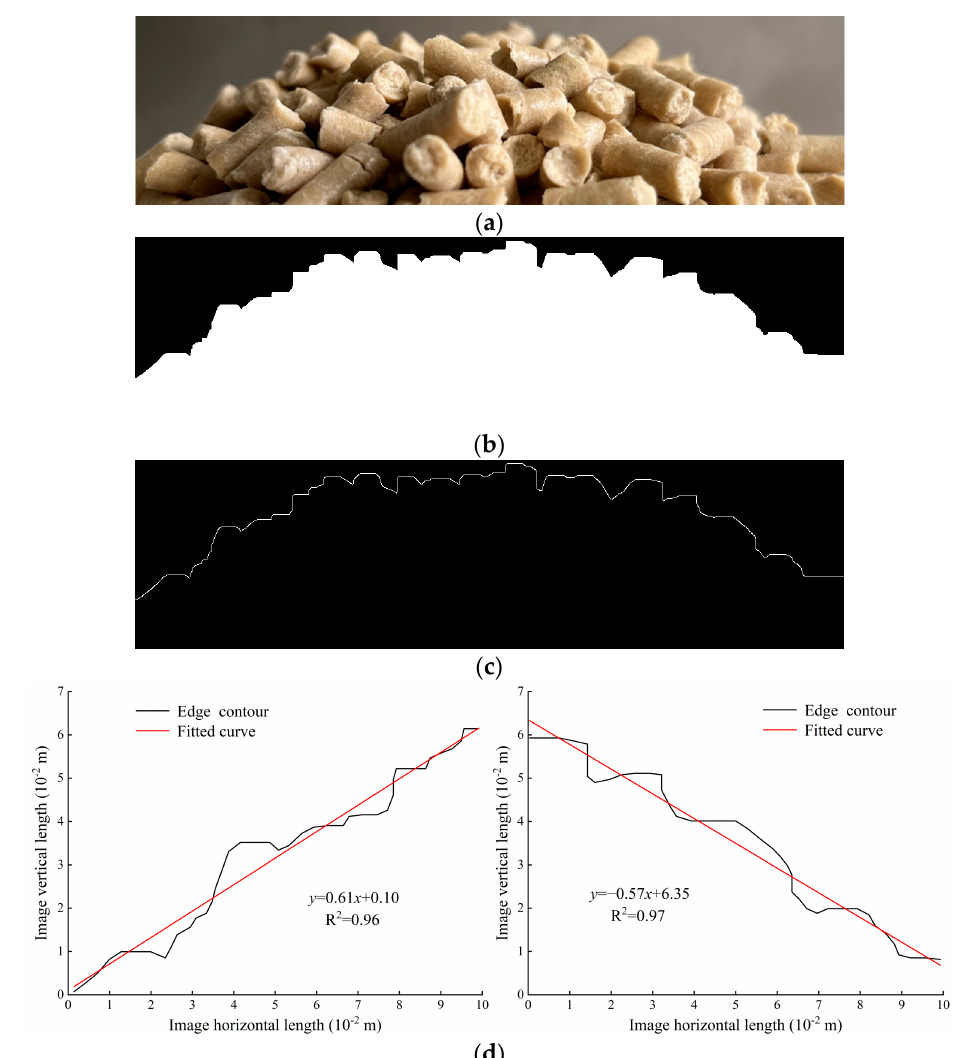
Figure 6. The angle of repose image processing. ( a ) Original image; ( b ) binary image; ( c ) contour extraction; and ( d ) contour line fitting.